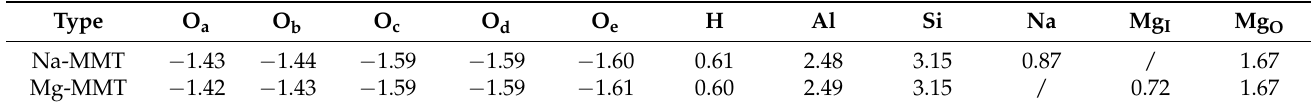
Table 5. Bader charges of various atoms of Na-MMT and Mg-MMT.